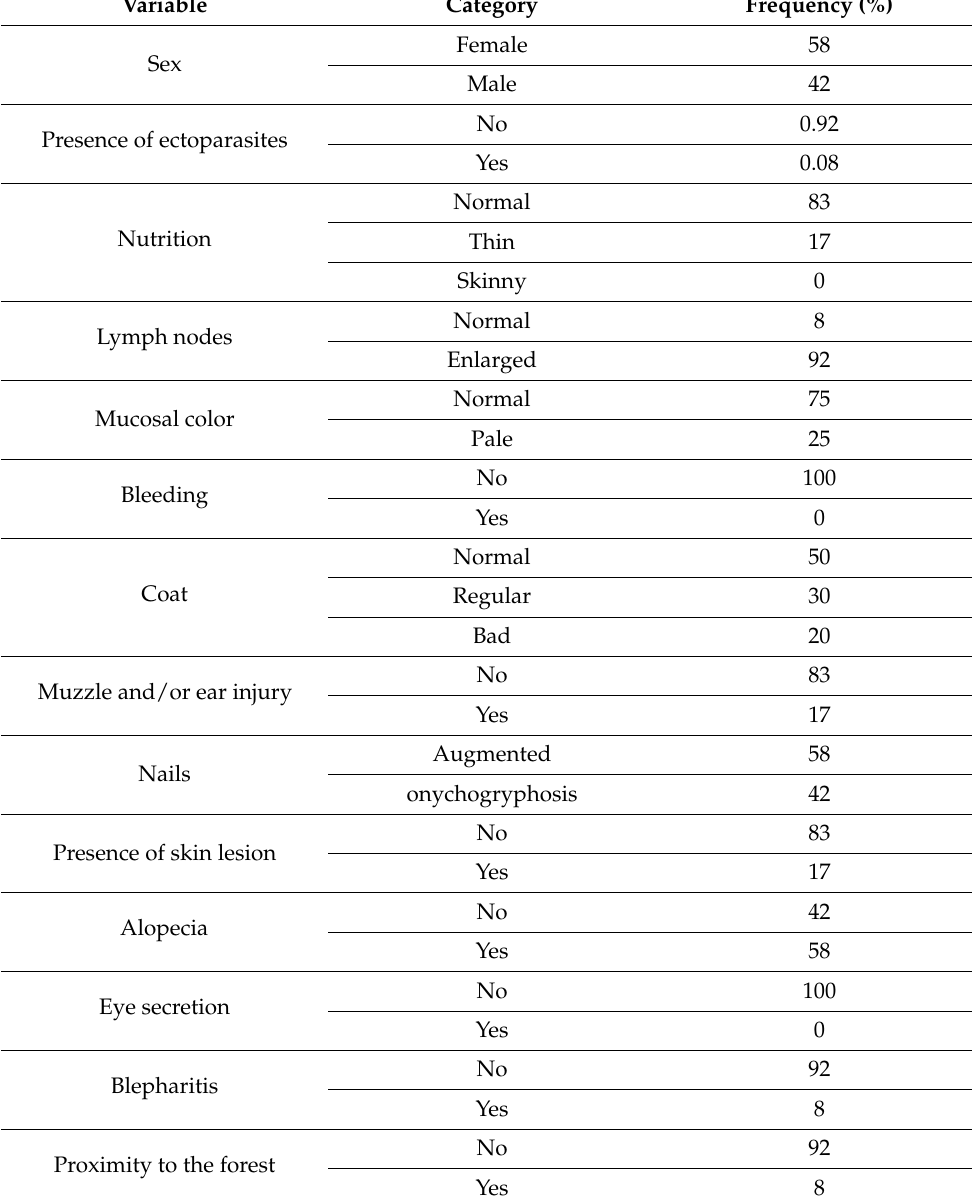
Table 6. Frequency of the variables for the false positive